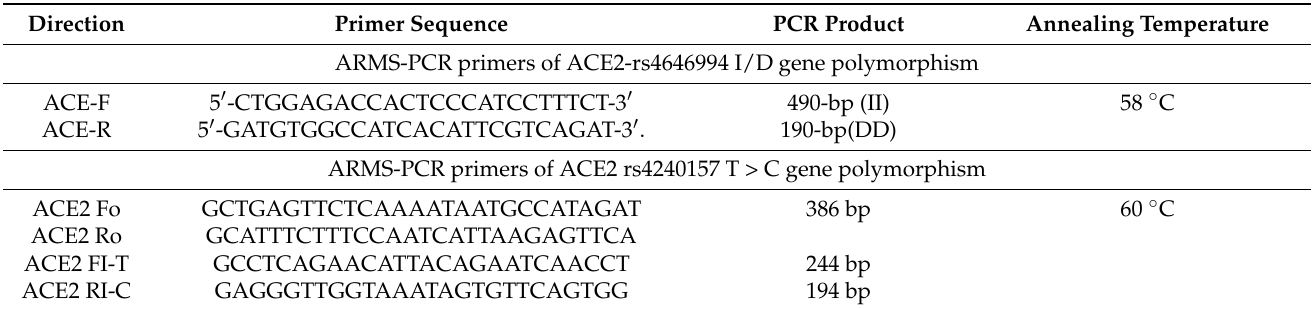
Table 1. Primers for ACE2 gene